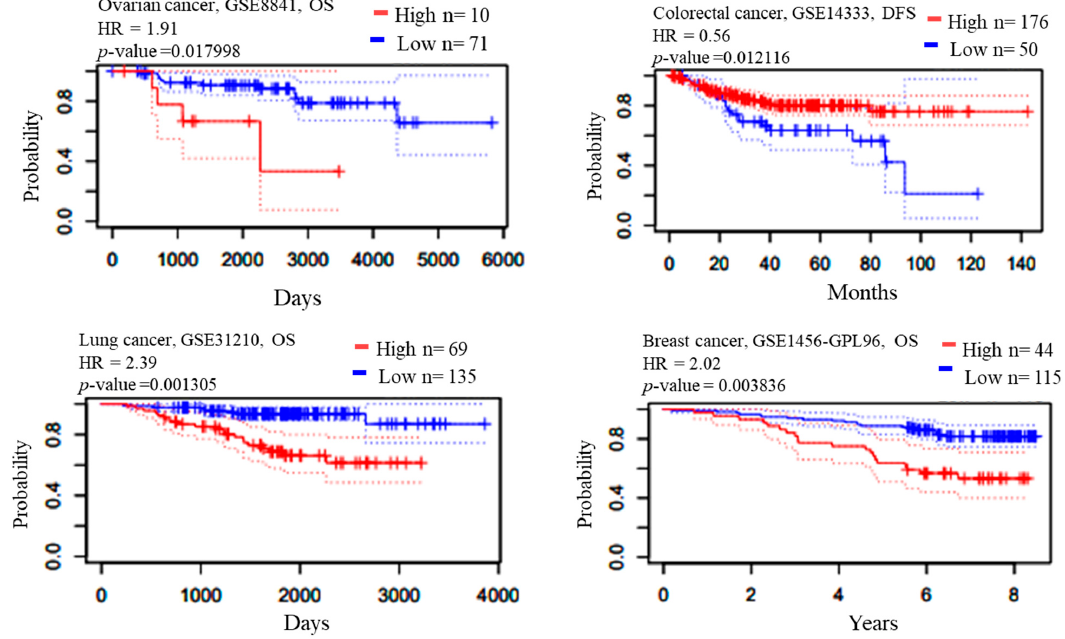
Figure 5. Clinical implication of CHEK1 in bladder, brain, ovarian, colorectal, lung, and breast cancer types. The survival curve comparing the patient with high (red) and low (blue) expression was plotted using the PrognoScan database with the threshold of a cox p -value < 0.05. Survival curves illustrate the prognosis of the patients with the CHEK1 gene. The percentage of patients reaching an endpoint was plotted on the vertical axis against time on the horizontal axis using the PrognoScan database to validate the prognostic value of CHEK1 expression in solid tumors (Figure 5). Table 2. The relationship between CHEK1 expression and survival in solid tumor clinical samples. Cancer PROBE ID N Cox p